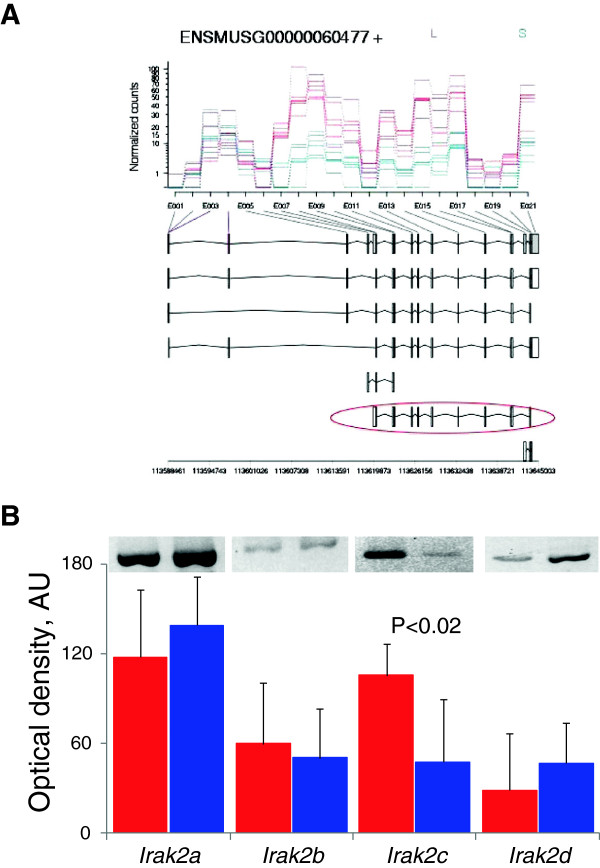
Splice variants of Irak2 gene in TA muscle from LG/J and SM/J strains. (A) Dexseq analysis identified differential expression of a number of exons between the LG/J (red line) and SM/J (blue line) strains. The pattern of differential expression overlapped with ENSMUST00000113024 transcript (outlined in red at the bottom) which corresponds to Irak2c splice variant [24]. (B) Abundance of the splice-specific PCR amplicones was compared between the strains (red – LG/J, blue – SM/J). Mean ± SD of six samples per strain (representative gels presented above corresponding bars).